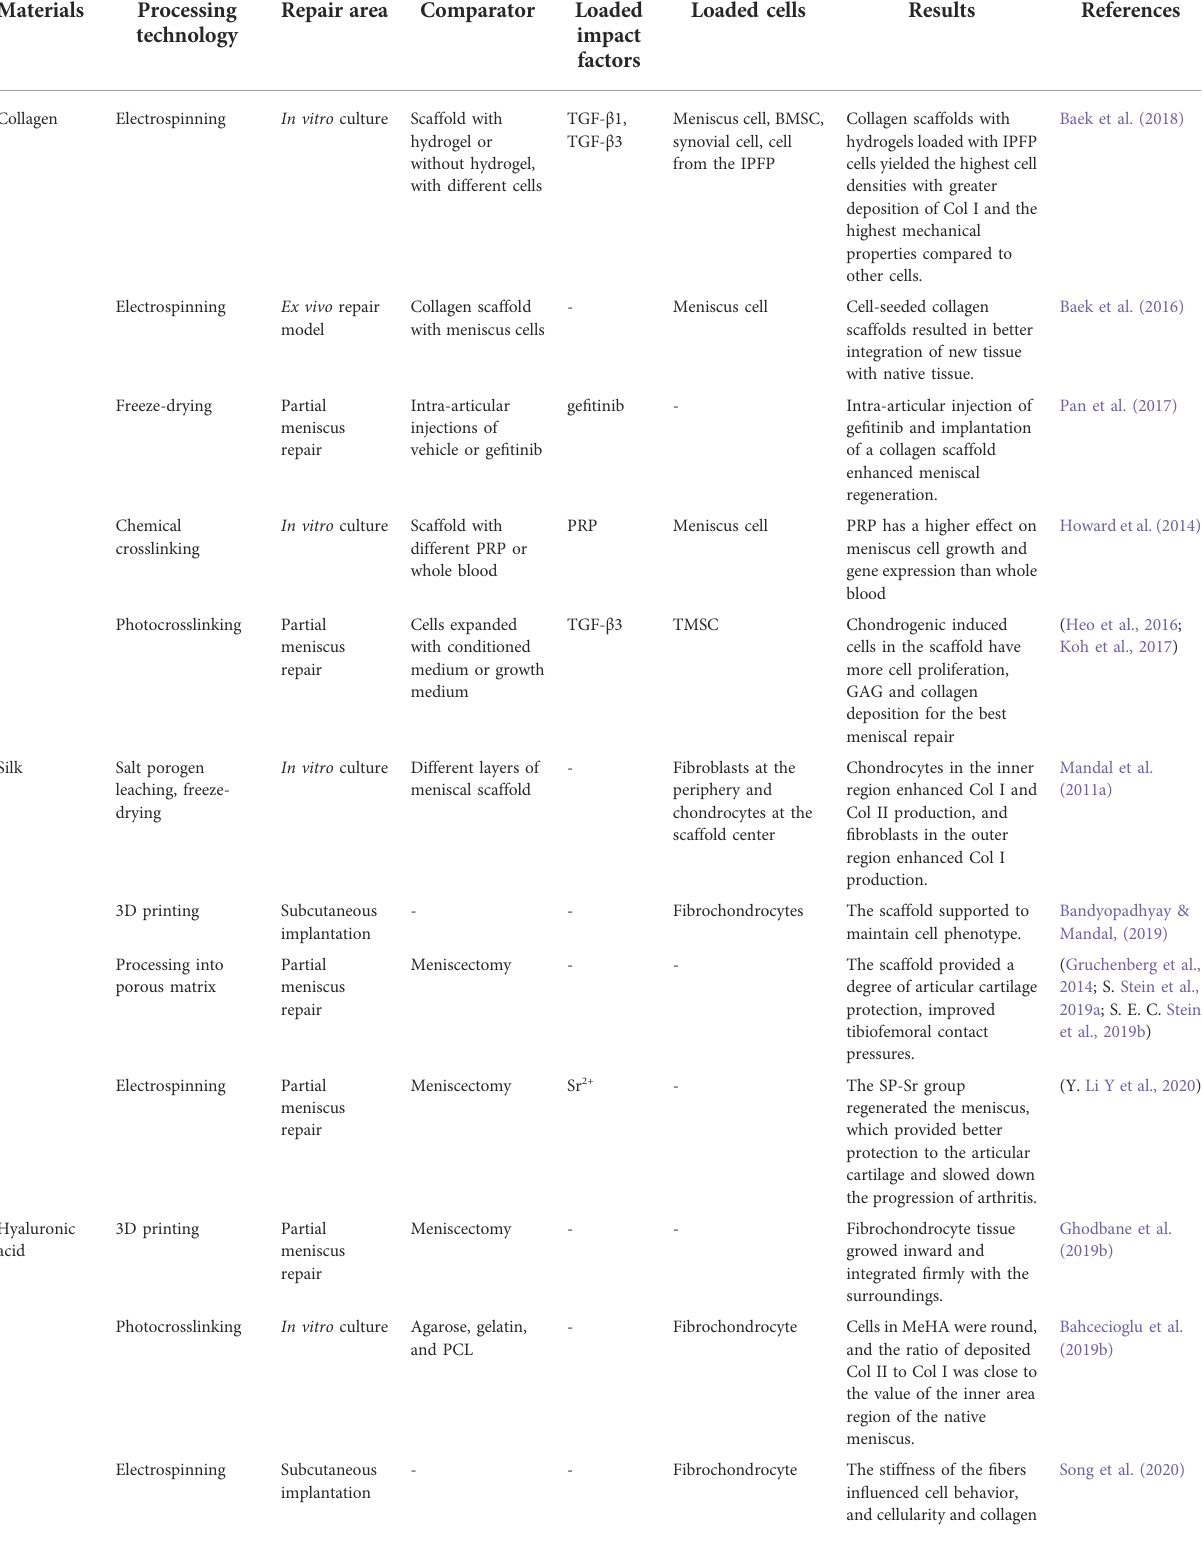
TABLE 1 Natural materials used for meniscus tissue